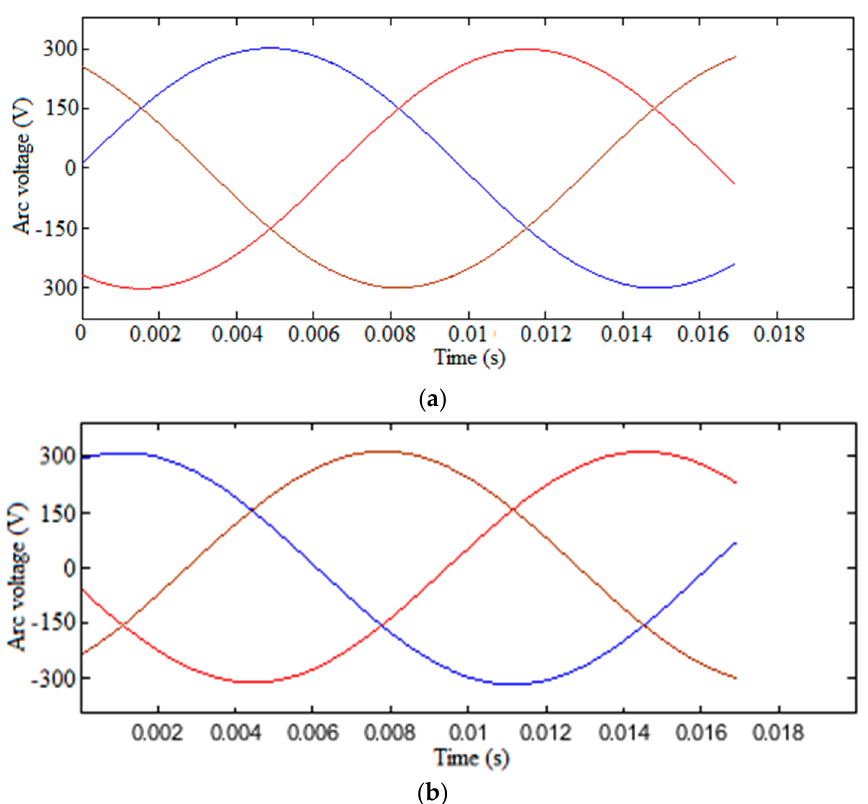
Figure 10. Waveform of arc voltage ( a ) Hybrid with MC, ( b ) Hybrid with MC and SVC .